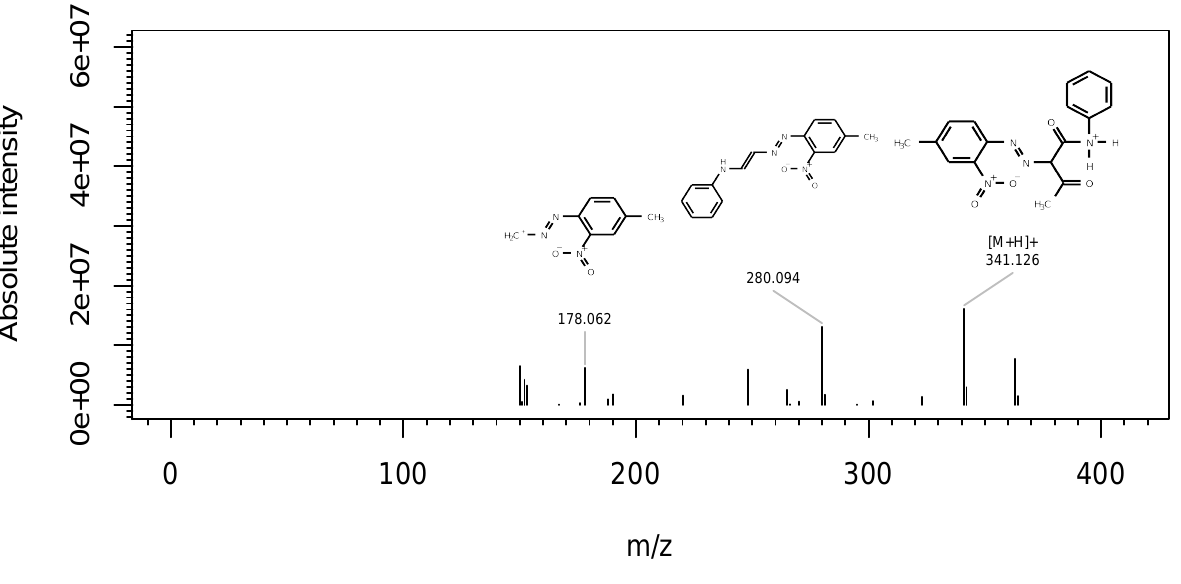
Figure A10. Challenge 13: annotated merged MS/MS spectra of benzyldiphenylphosphine oxide (ESI, positive